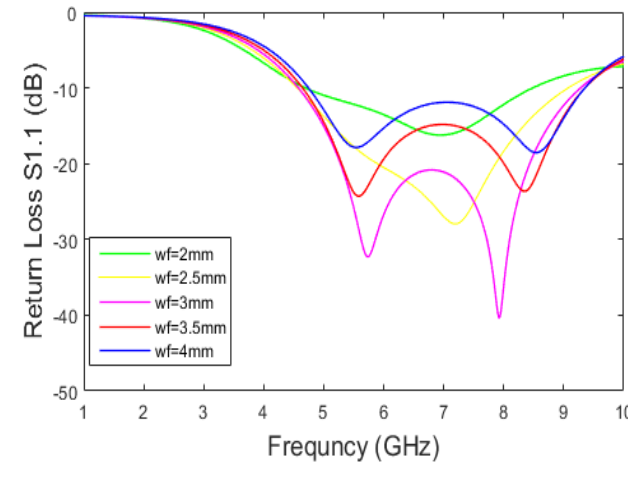
Figure 7 Simulated Return Loss S1.1 for Various Values of width of ground W f